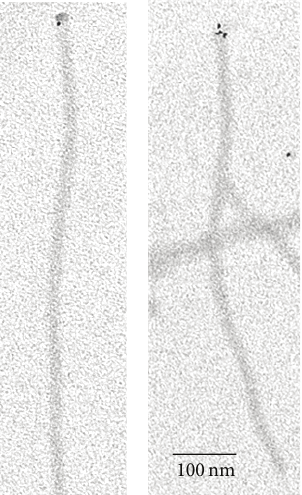
Figure 3: Polar binding of the platinum atom clusters to PVX particles. Sample preparation described in Section 2. Specimen was examined under TEM Zeis LEO912 AB OMEGA microscope, no contrasting of